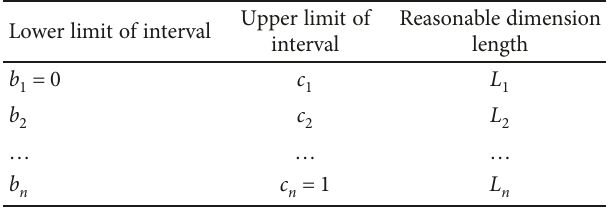
Table 3: Selected intervals of reasonable dimension length after dimensionality